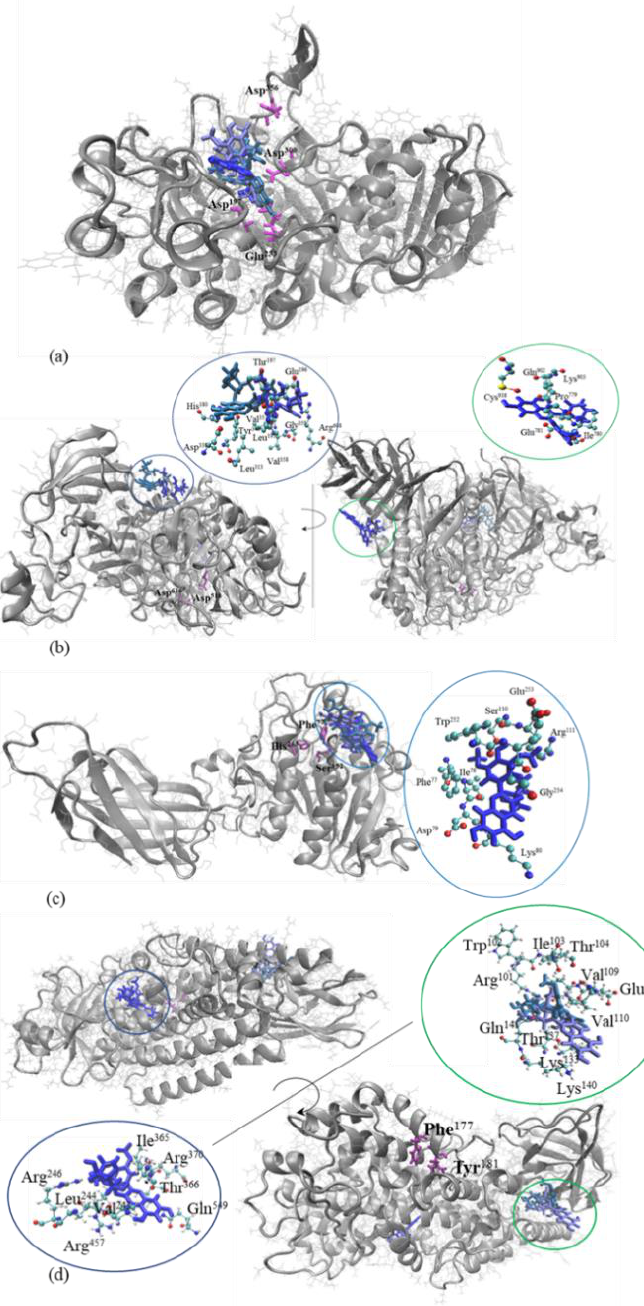
Figure 7. Superposition of the top three scoring models resulting from the molecular docking tests, showing the complexes formed by α -amylase ( a ), α -glucosidase ( b ), lipase ( c ), and lipoxygenase ( d ) represented in silver, with M3G is represented in different shades of blue in licorice style. The catalytic amino acids are highlighted in purple. The insets present details on the ligand binding sites. Images were prepared using VMD software.